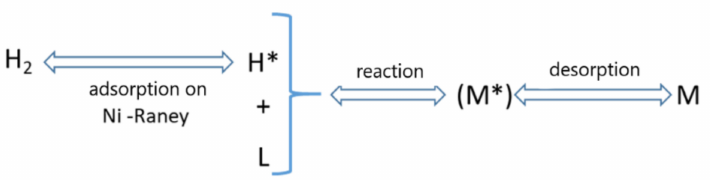
Figure 13. Reaction scheme related to the catalytic hydrogenation of lignin. L = lignin, M = monomers, * = activated